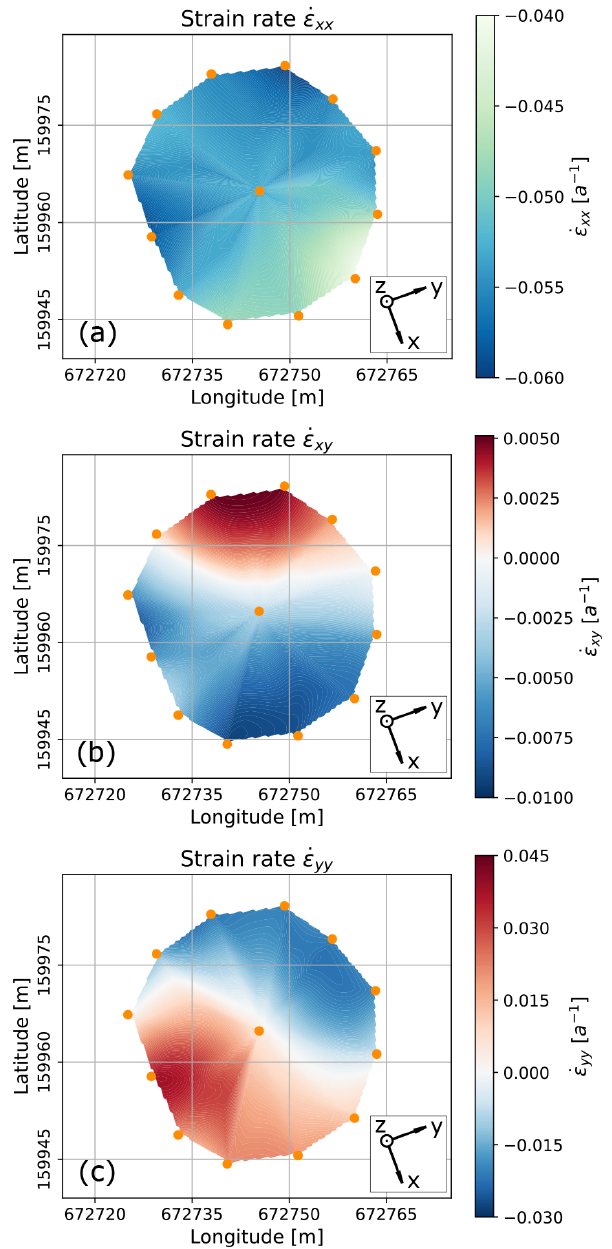
Figure 3. Strain rate components at the surface derived from the ice flow velocity pattern shown in Fig. 2b. (a) ˙ (cid:15) xx , (b) ˙ (cid:15) xy and (c) ˙ (cid:15) yy ; compressional strain rates are negative values; orange dots depict the boreholes; insets depict the glacier flow coordinate